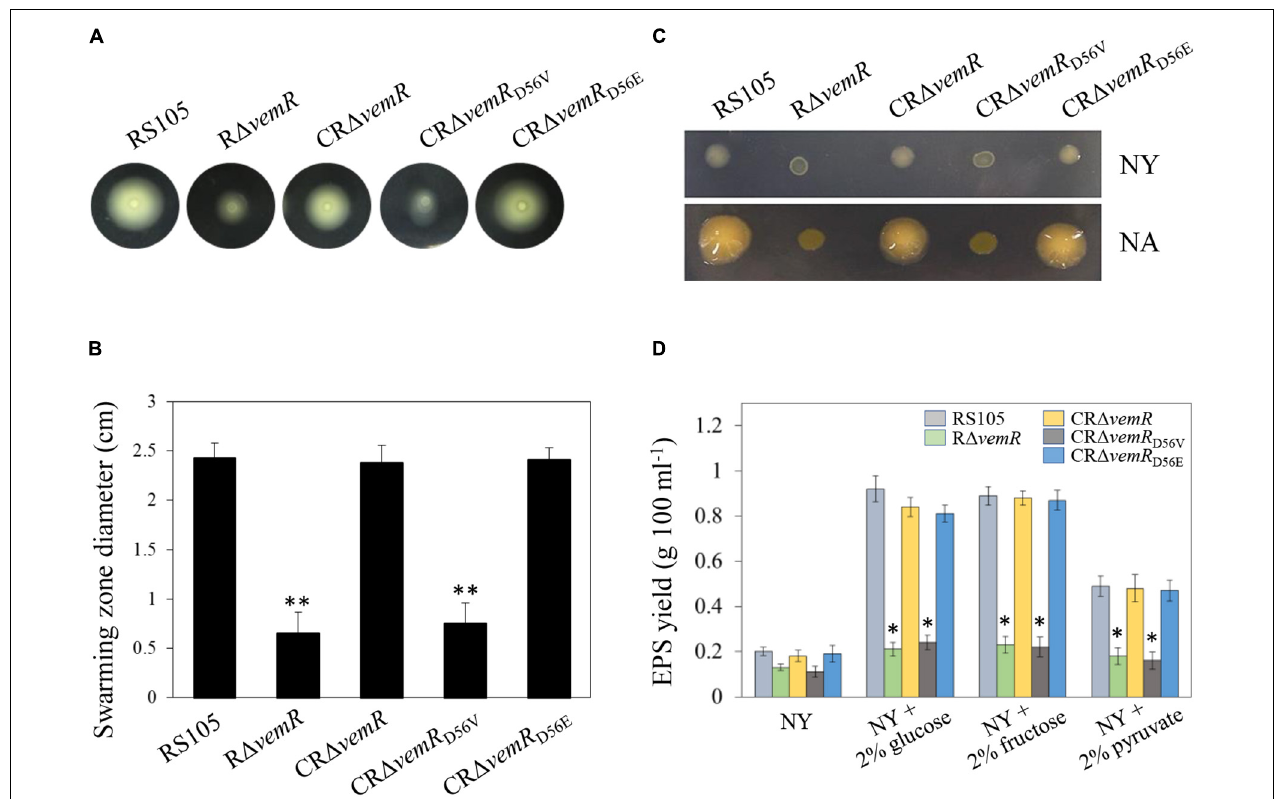
FIGURE 3 | vemR is required for motility and EPS production in X. oryzae pv. oryzicola ( Xoc ). (A,B) Swarming motility of Xoc strains on NY medium containing 0.5% glucose. The data were scored at 2 days after inoculation. (C) Colony morphology and (D) EPS yield of Xoc strains in liquid NY medium and NY medium supplemented with 2% glucose, fructose, or pyruvate. Data presented are the mean ± standard deviation (SD) from three independent experiments with five replications each. Student t -test ( p = 0.01 and 0.05) was used to separate significantly different means denoted by ** and *,